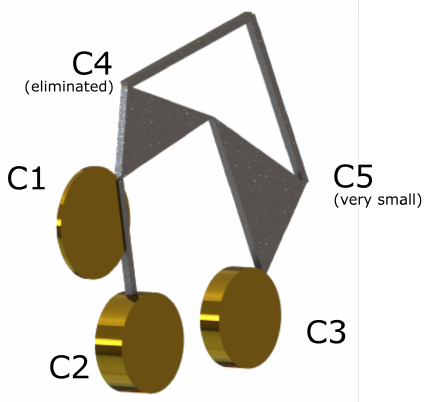
Figure 8. Conceptual implementation of the third solution from the Pareto front for the six-bar mechanism using five counterweights C i .